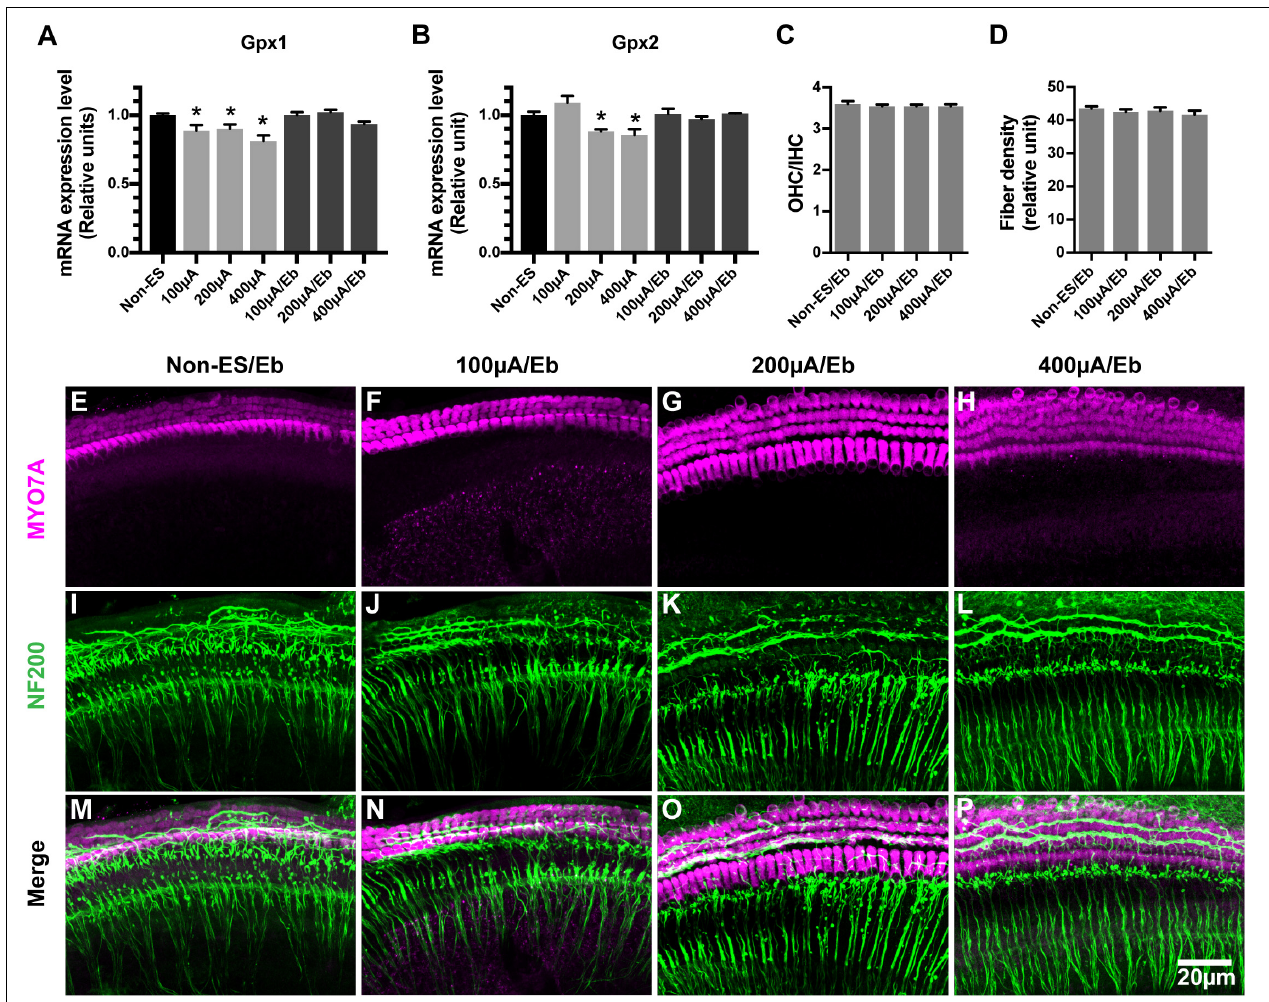
FIGURE 7 | The mRNA expression level of GPx1 and GPx2 in cochlear explants decreased under ES and ebselen abolished this effect and the loss of SGN peripheral fibers. (A,B) ES treatment of 200 and 400 µ A/48 h both significantly decreased the mRNA expression level of both GPx1 and GPx2 in explants while 100 µ A/48 h-ES treatment only decreased the mRNA expression level of GPx1 ( ∗ , GPx1: 200 µ A, P = 0.0231; 400 µ A, P = 0.0233; GPx2: 200 µ A, P = 0.0484; 400 µ A, P = 0.0228, when compared to non-ES group, n = 3 in each group, measurements were repeated three times). When the cochlear explants were treated with ES and 40 µ M Ebselen at the same time, mRNA expression level of GPx1 and GPx2 was comparable to that in non-ES group (GPx1: 100 µ A/Eb, P > 0.9999; 200 µ A/Eb, P = 0.9738; 400 µ A/Eb, P = 0.4027; GPx2: 100 µ A/Eb, P > 0.9999; 200 µ A/Eb, P > 0.9999; 400 µ A/Eb, P > 0.9999 compared to non-ES group). When the cochlear explants were treated with 40 µ M Ebselen, OHC/IHC ratio ( C , P = 0.7997, P = 0.7629, P = 0.7639, in each group.) and the density of SGN peripheral fibers ( D , P = 0.7860, P = 0.9025, P = 0.3482, n = 20 in each group.) in 100, 200, and 400 µ A/48 h-ES groups had no significantly statistical difference from those in the non-ES group. (E–P) Representative images showed that there was no significant loss of hair cells (in magenta) and SGN peripheral fibers (in green) in ES-treated explants when they were maintained in medium with 40 µ M Ebselen. Data represented the mean +